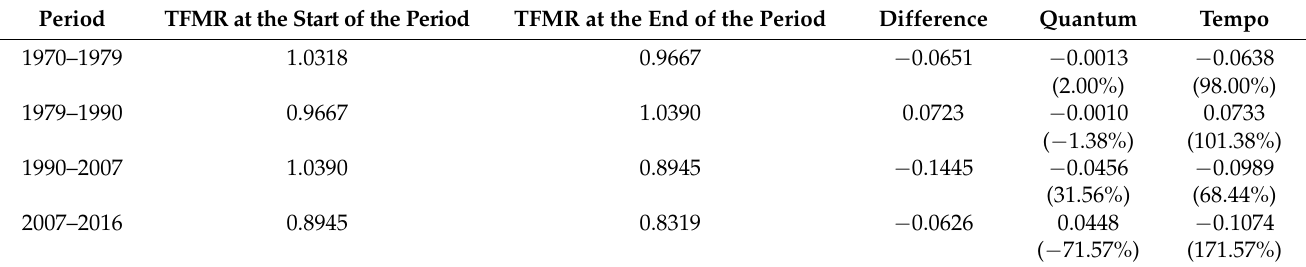
Figure 4. Decomposition of changes in TFMR into quantum change and tempo effect, 1970 – 2016. Source: 2005 China 1% Population Sample Survey and the 2017 China Fertility Sample Survey. Table 1. Contribution of quantum and tempo components to changes in TFMR, 1970 – 2016.